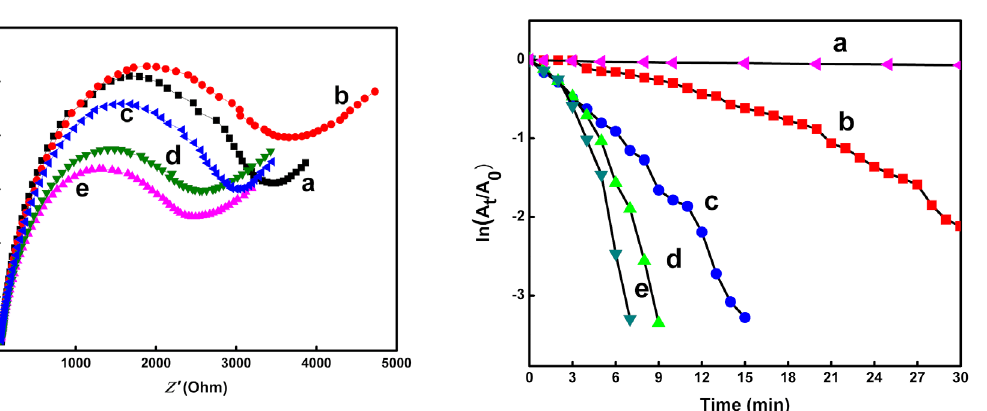
Fig.6 Nyquist plots of CPE (a), PNA/CPE (b), Gr-Ag-5/PNA/ CPE (c), Gr-Ag-10/PNA/CPE (d), and Gr-Ag-20/PNA/CPE (e)